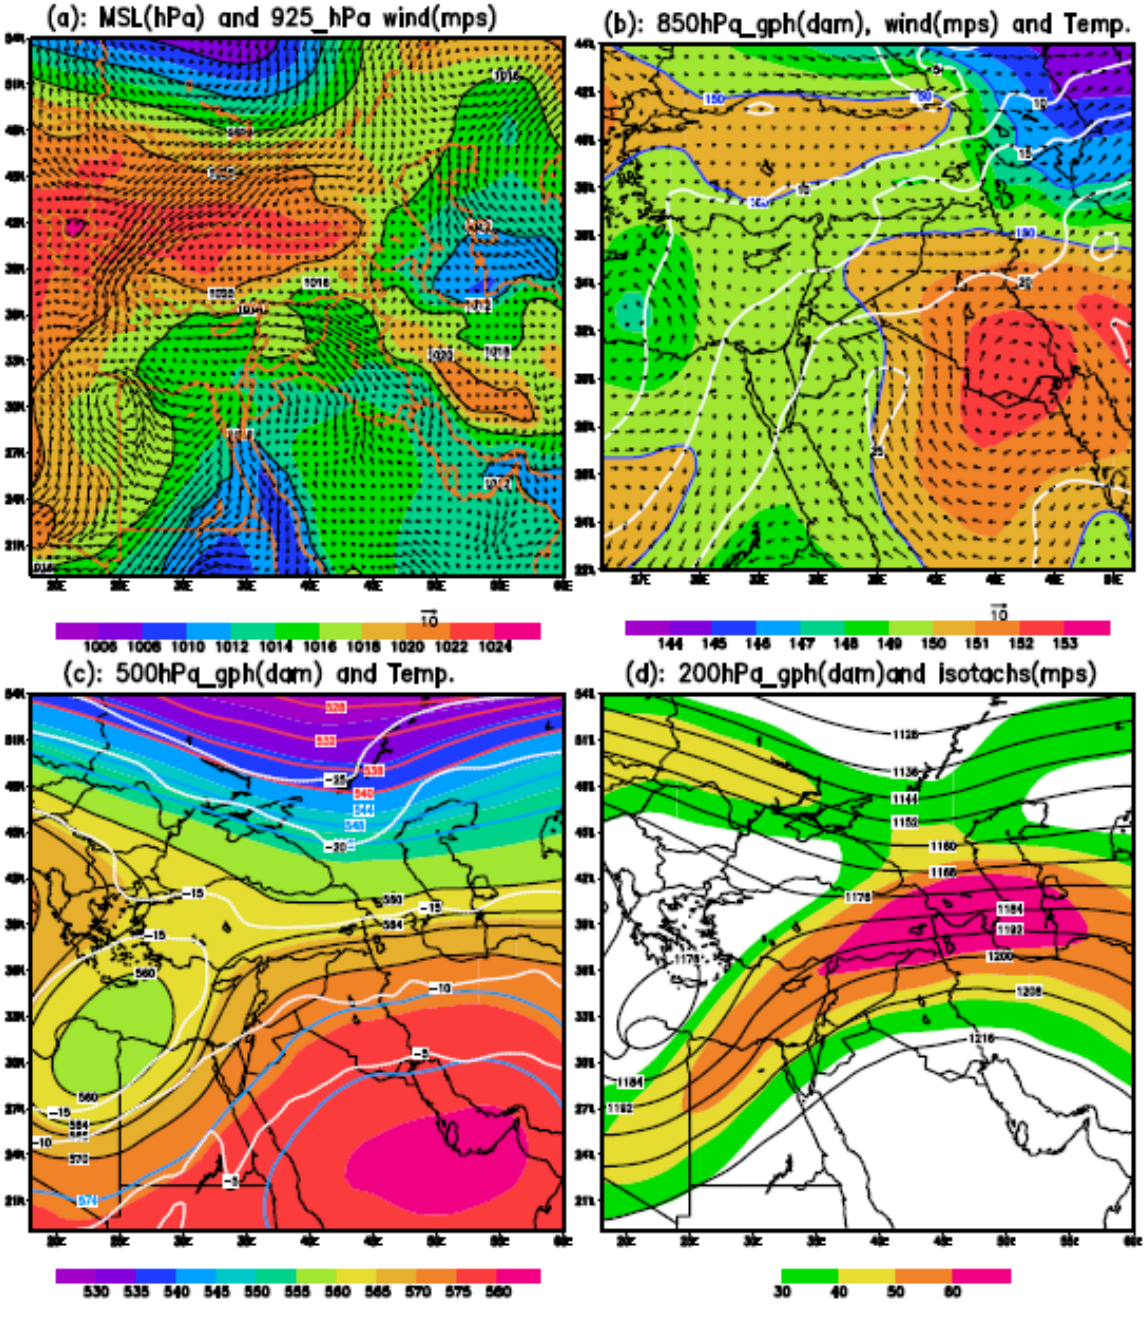
Figure A2. Same as Figure 10 but for 00 UTC 27 October 2017. At 00 UTC on 28 October 2017 (Figure A3), two large low-pressure systems (pink and blue shaded colors) were located north of the Black Sea (BS) and the Northern Red Sea (RS), resulting in a large trough stretching from the MS through Iraq (Figure A3a). Furthermore, two large high-pressure systems were located over two sides of the low pressures, and the northwesterly winds over Iraq were strengthened. A longwave trough was located over the northwest of the BS, as was a weak trough over the eastern MS. An upper high extended from Iran to the west of the CS, with southerly winds extending from Saudi Arabia to Northern Iraq at 850 hPa (Figure A3b). A temperature gradient was observed across Southeastern Mississippi and Northern Iran. A deep trough located northwest of the RS at 500 hPa elongated a ridge over Iran and Iraq (Figure A3c). The geopotential